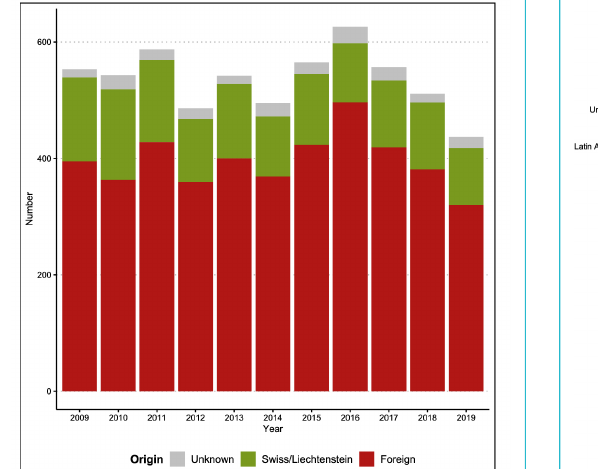
Figure 2: Distribution of foreign regions of origin among tuberculo- sis cases in Switzerland and Liechtenstein, 2009–2019. Eastern Africa includes Eritrea, Somalia, Ethiopia, Kenya, and Tanza-nia; South-East Europe Kosovo, Serbia, Montenegro, Bosnia and Herzegovina, Macedonia, Romania, Albania, Croatia, Bulgaria, and Slovenia; Southern Asia India, Sri Lanka, Afghanistan, Pak-istan, Nepal, and Bangladesh. The country of origin was missing in 216 cases (see table 1), and in 27 cases origin was reportedly non-Swiss, but without specifying the